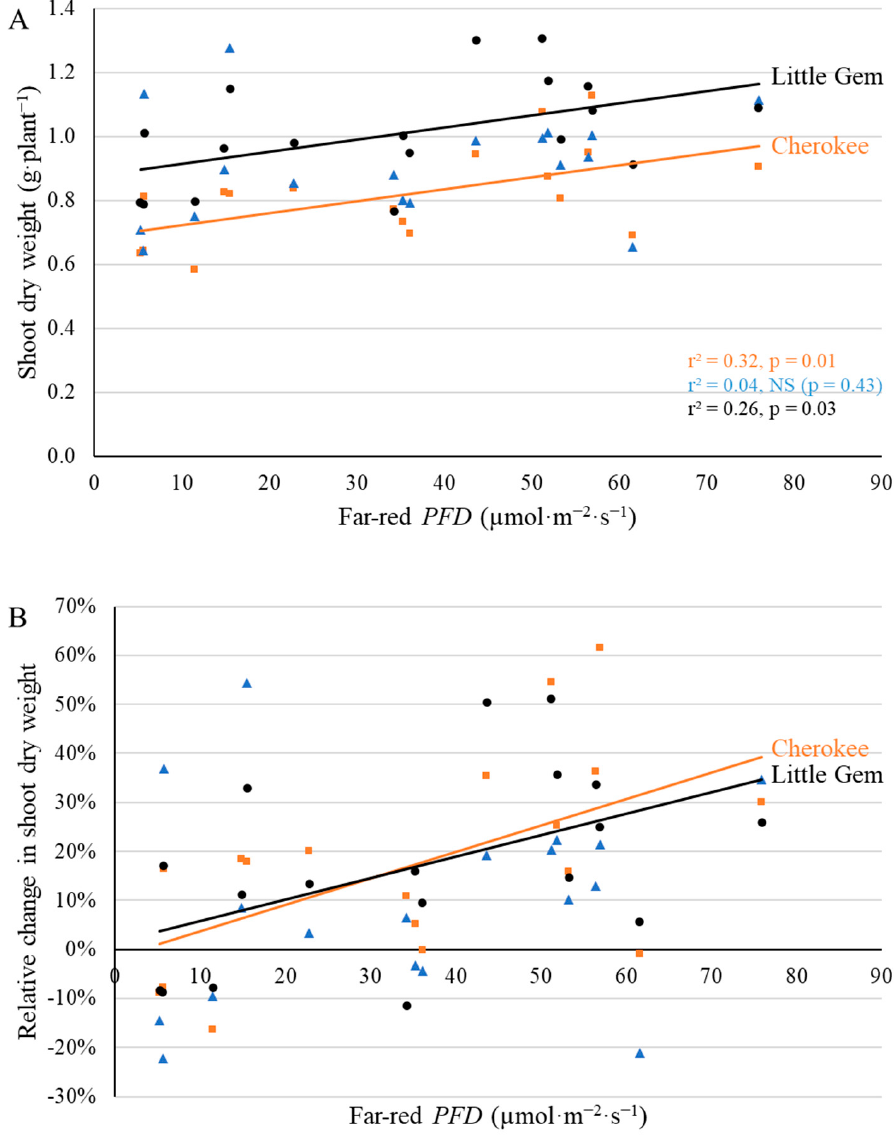
Figure 11. With a background of 204 µ mol · m − 2 · s − 1 white LED light, supplemental far-red photons linearly increased shoot dry weight ( A ) and relative shoot dry weight (( B ), compared to plants under no supplemental far-red light) at 20 days after the start of far-red light treatment for ‘Cherokee’ and ‘Little Gem’, but not for ‘Green Saladbowl’ (blue triangles) lettuce. The r 2 and p values for regression of each cultivar apply to both graphs and are shown with the respective color.